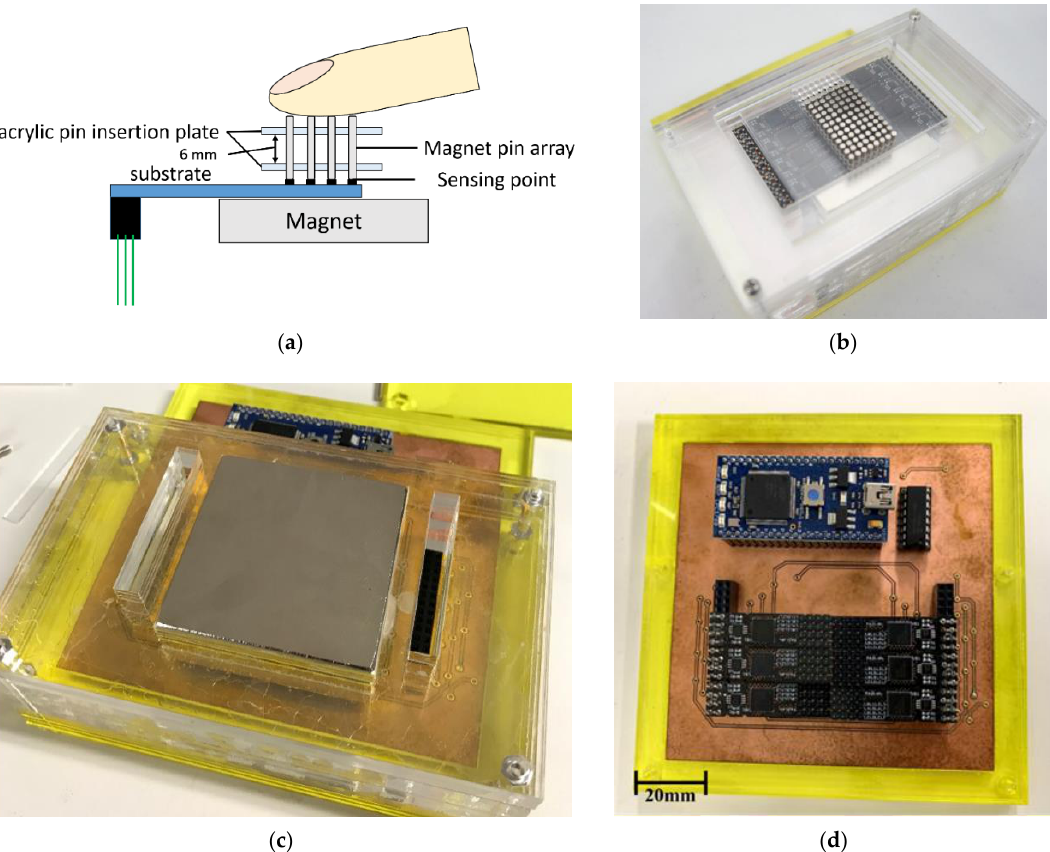
Figure 2. Measurement system based on magnet ( a ) structure, ( b ) oblique view, ( c ) base magnet, and ( d ) circuit board of sensing device. The attractive force between the base magnet and the pin magnets works as a preload to the load cell at the sensing point, enabling measurement of tensile force distribution of adhesive material. Six load cell substrates are mounted on the base board, constituting 96 measurement points.